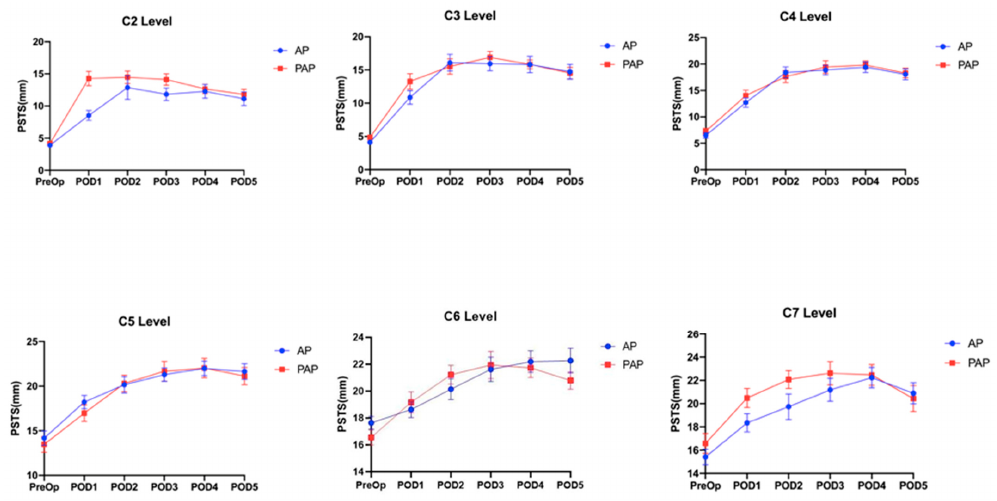
Figure 3. PSTS measurements from the C2 to C7 level between AP and PAP surgery across the different PODs .